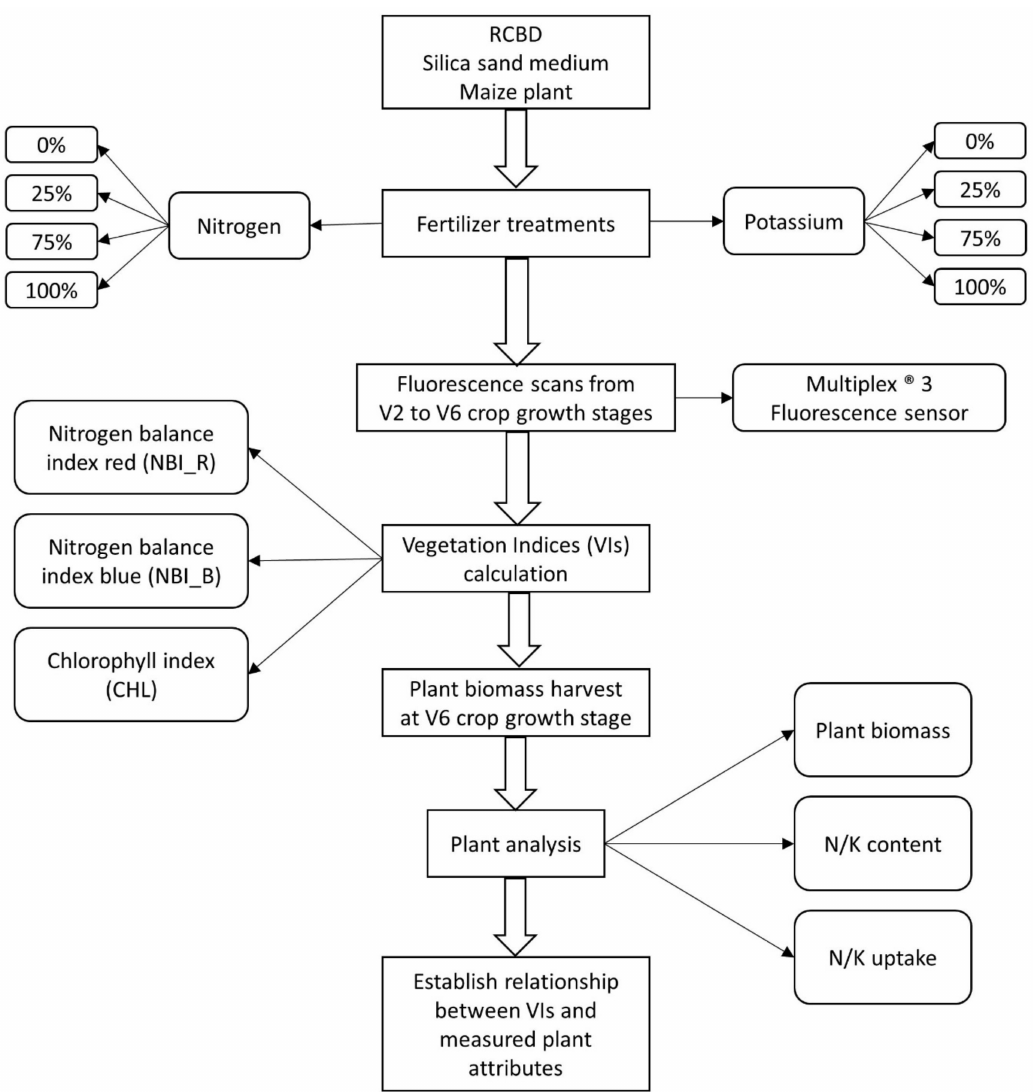
Figure 1. Flow chart of the methodology. RCBD = Completely randomized block design, VI = Vegetation